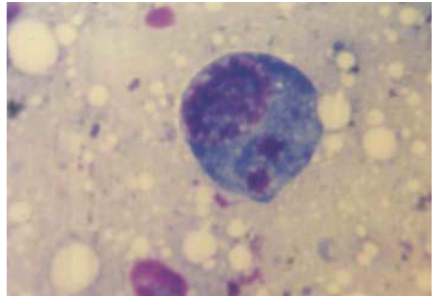
Figure 4: Cell of a Solenopsis richteri larva infected with a binucleate vegetative stage of Kneallhazia solenopsae . Giemsa’s stain,